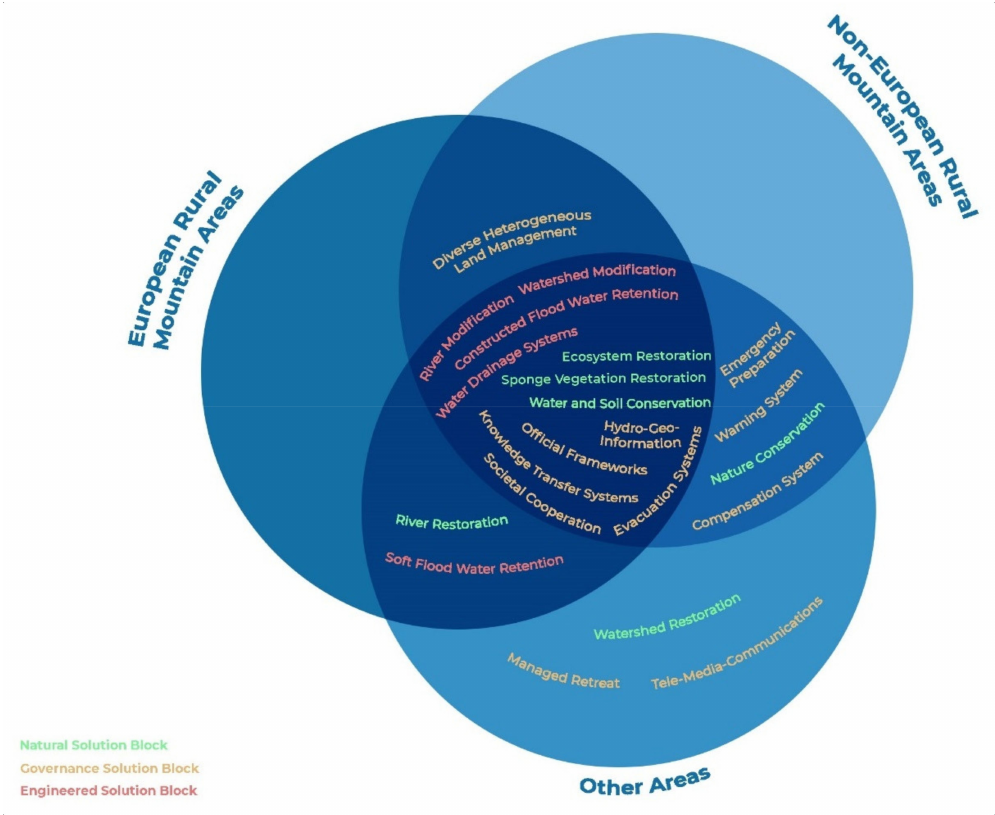
Figure 3. Distribution of the FM measures (FMM) presented in each sub-data